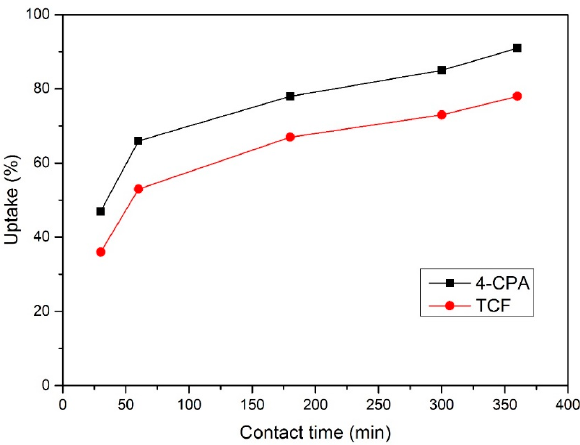
Figure 6. Uptake percentage for each pesticide.